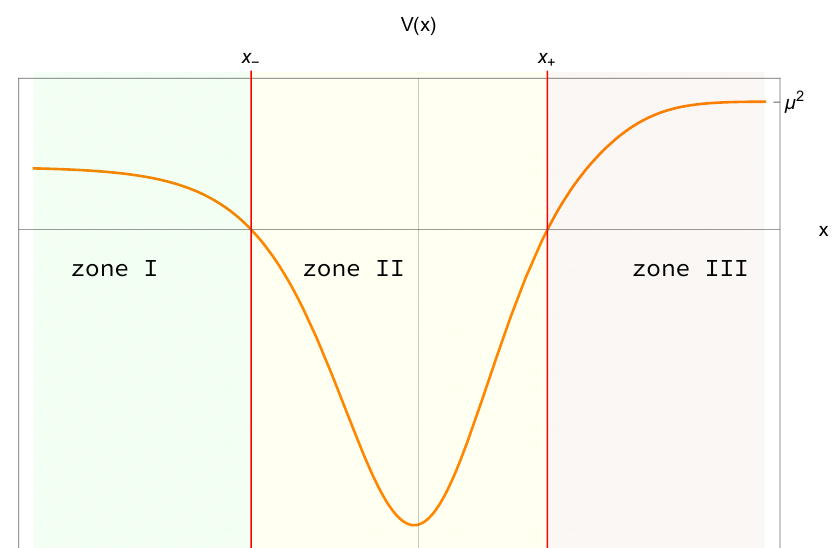
Figure 4: Schematic description of a potential V ( x ) with the two turning points, x − and x + and the three zones depending on the sign of V ( x ) . For the illustration, we have considered that V ( x ) tends to a constant at −∞ but it is not necessary for the discussion. Any kind of behavior is possible as long as V ( −∞ ) ≥